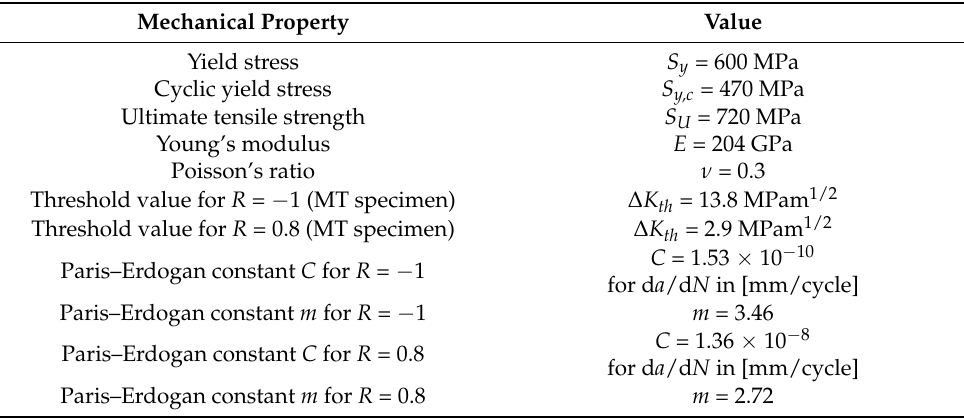
Figure 5. Microstructure of the investigated Cr-Mo low-alloy steel (EA4T steel). Table 2. Mechanical properties of the investigated EA4T steel. Values related to fatigue crack behavior were determined on the middle crack tension specimens (MT) with the width of 60 mm, thickness of 5 mm at 23 ◦ C and 50% relative